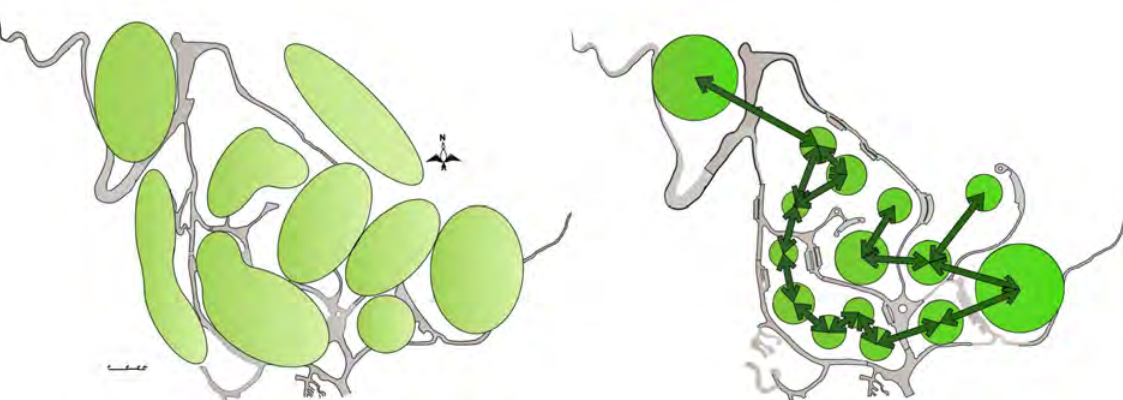
Figure 10. Park landscaping concept, dividing the area into different green spaces, on different levels (Source: Author).